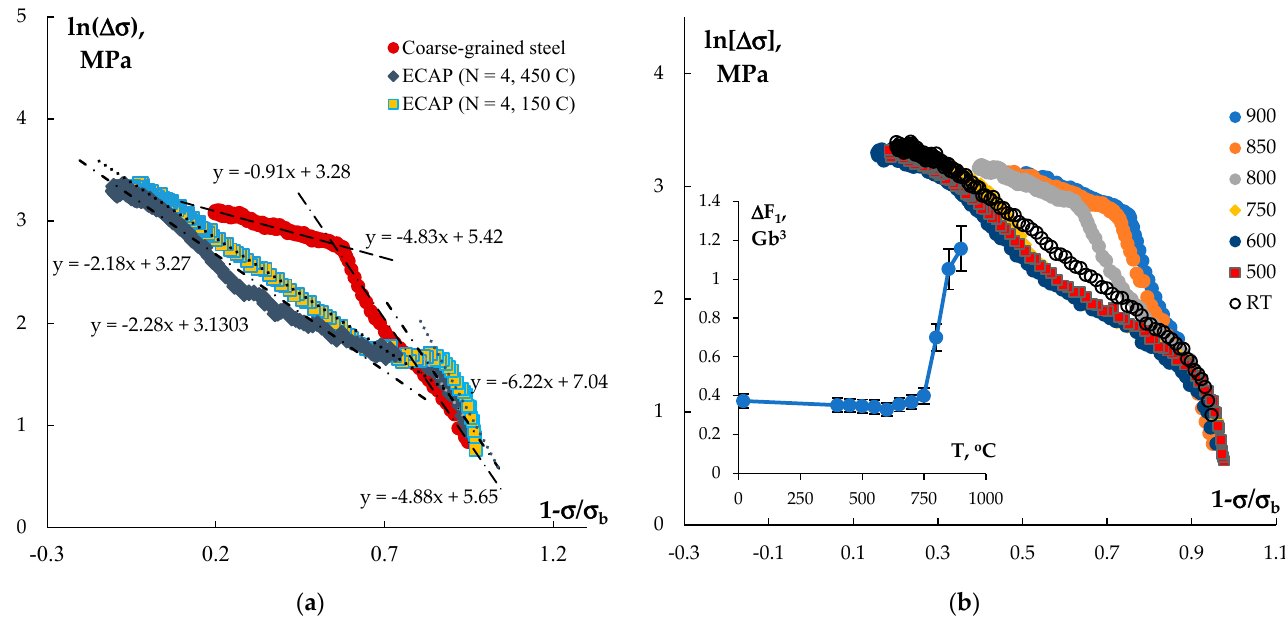
Figure 17. Dependences of stress-relaxation magnitude on stress applied on ln( ∆σ i ) − 1 −σ / σ b axes: ( a ) comparison of CG and UFG steels (analysis of the data presented in Figure 12a); ( b ) effect of annealing temperatures on relaxation curves for UFG steel (analysis of the data presented in Figure